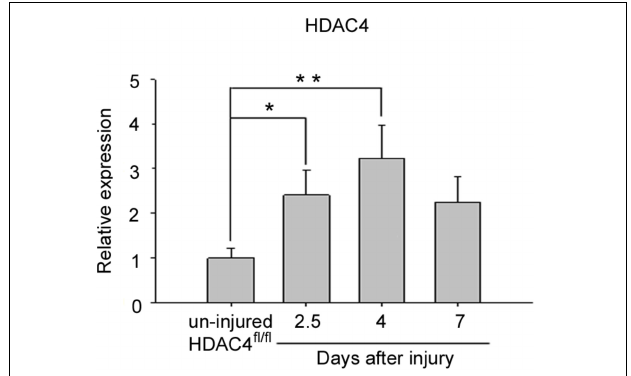
FIGURE 1 | HDAC4 expression is up-regulated in regenerating HDAC4 fl/fl muscles. Real-time PCR for HDAC4 in regenerating muscles, at the indicated time points following injury, over un-injured muscles. Data are presented as mean +/– SEM. n = 6 mice for each condition. One-way ANOVA showed a significant effect of the treatment between groups ( F = 5.16; df = 3; p = 0.01) and a significant interaction between un-injured HDAC4 fl/fl mice and 2.5 days ( ∗ p < 0.05) or 4 days ( ∗∗ p < 0.01) after injury by Tukey’s HSD